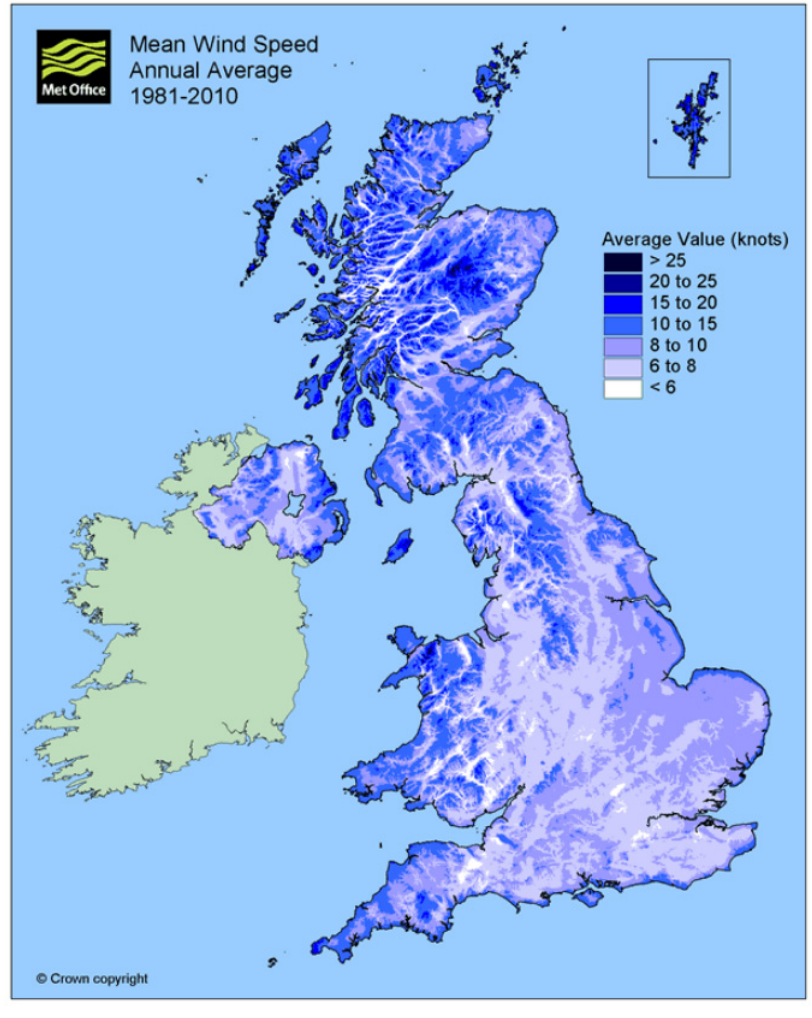
Figure 1. Scotland’s mean annual wind speed [18]. Table 2. BEIS Pure LCOE